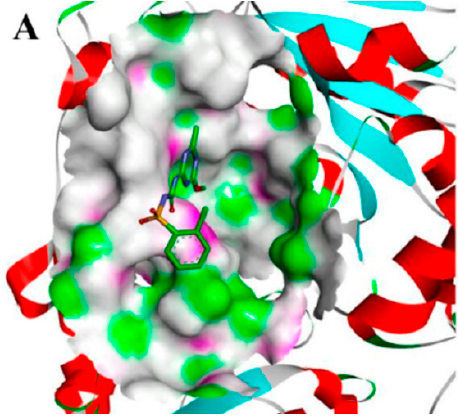
Molecules 2019 , 24 , x FOR PEER REVIEW Figure 2. The docking model of chlorsulfuron with the acetolactate synthase (ALS) active site.